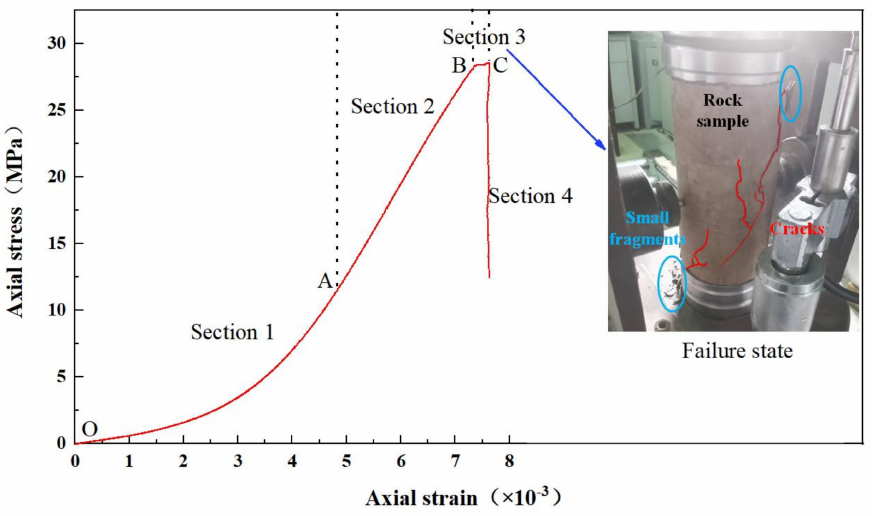
Figure 5. Stress-strain curve of the KY0-2